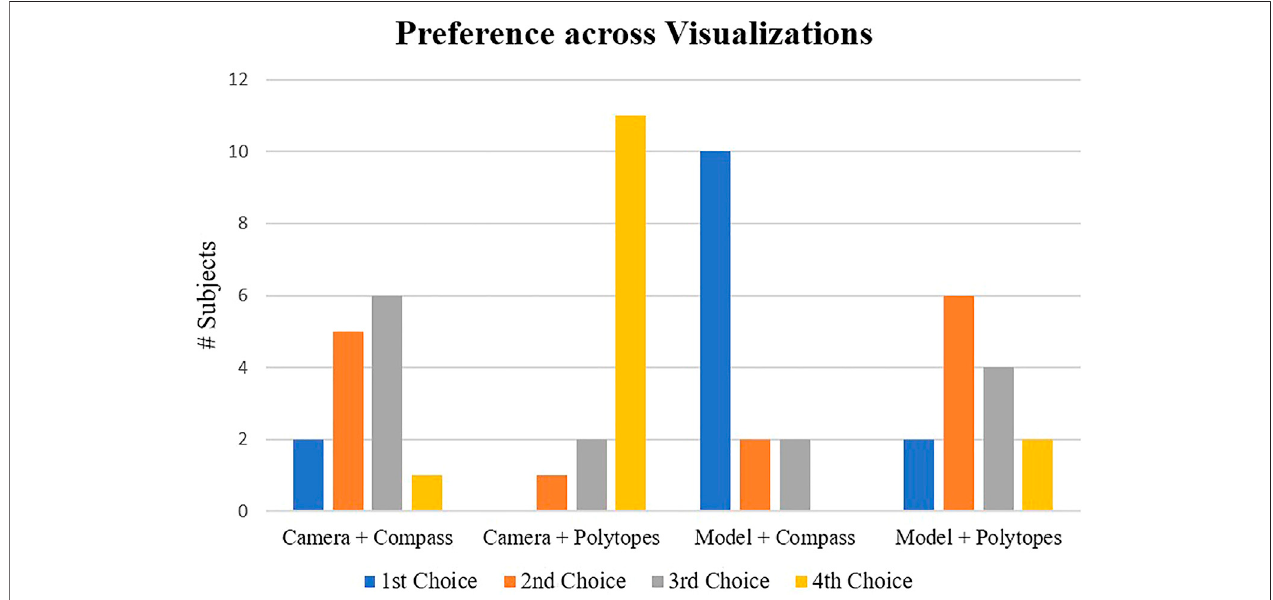
FIGURE5| Userpreferenceratingsacrossthefourvisualizationprototypesfromthepilotstudy.Thereisaclearmajorityof “ 1stChoice ” and “ 4thChoice ” selections for the “ Model + Compass ” and “ Camera + Polytopes ” visualizations, respectively.